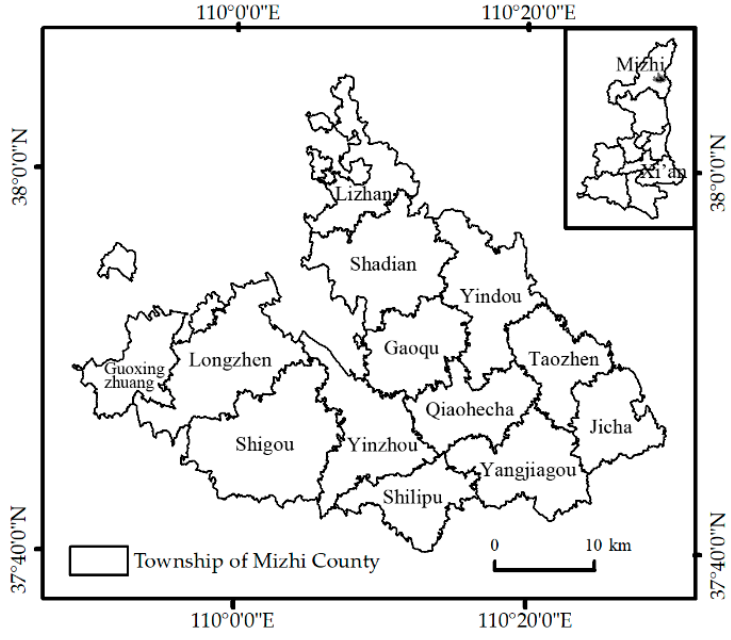
Figure 1. Location of the study area.